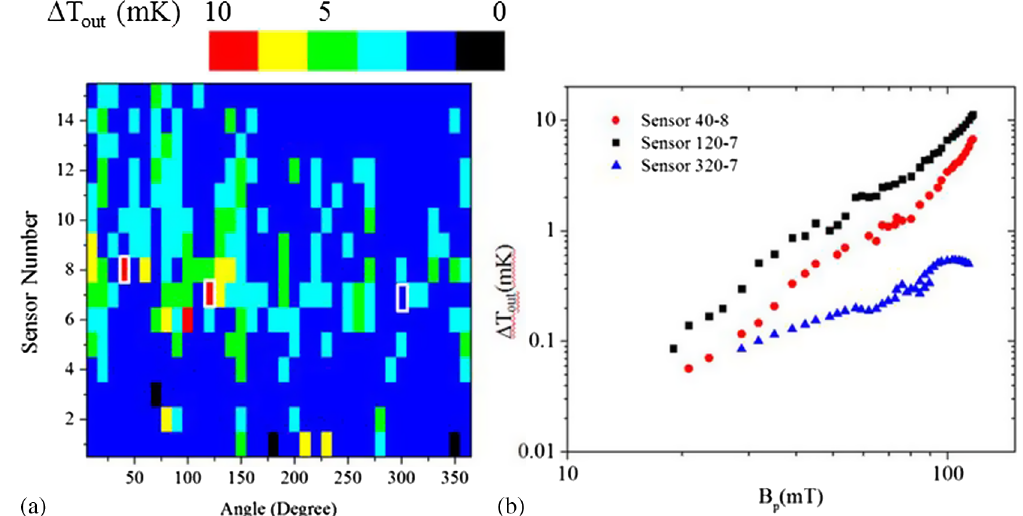
measured at three out